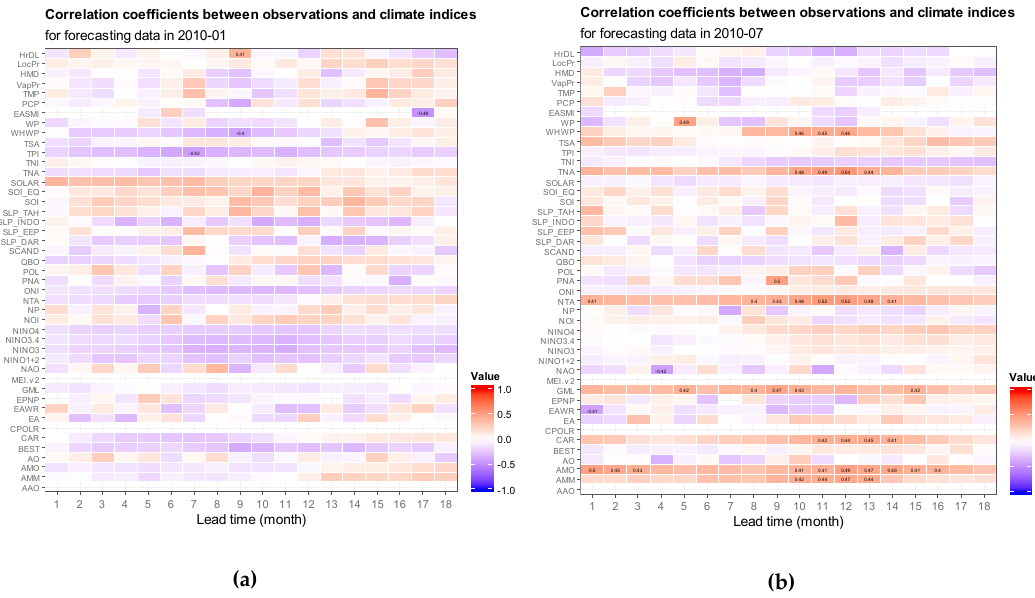
Figure 2. Results of the correlation analysis with predictors for forecasting the precipitation of ( a ) January and ( b ) July 2010.